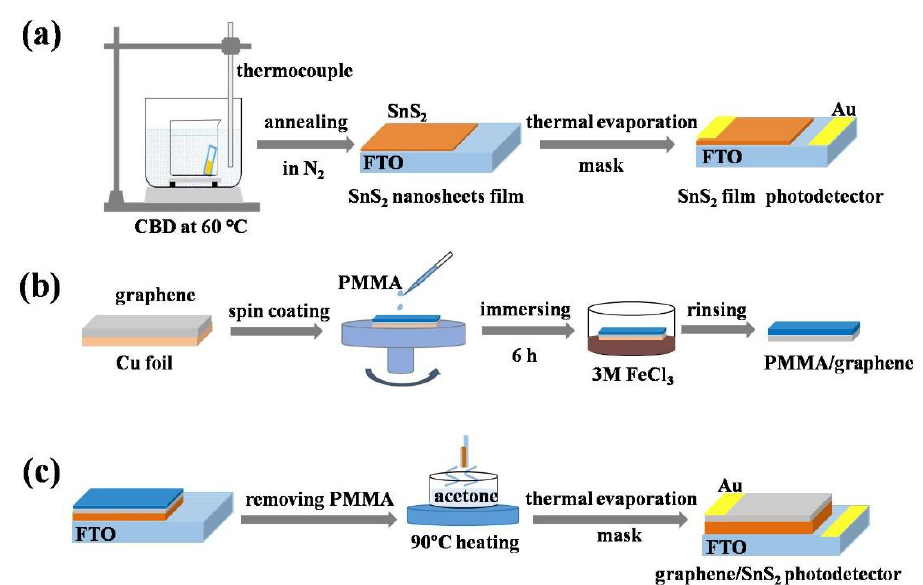
Figure 1. Schematic of ( a ) chemical bath deposition (CBD) process for SnS 2 nanosheets film; ( b ) preparation of the floating graphene film; ( c ) preparation of the graphene/SnS 2 heterojunction.